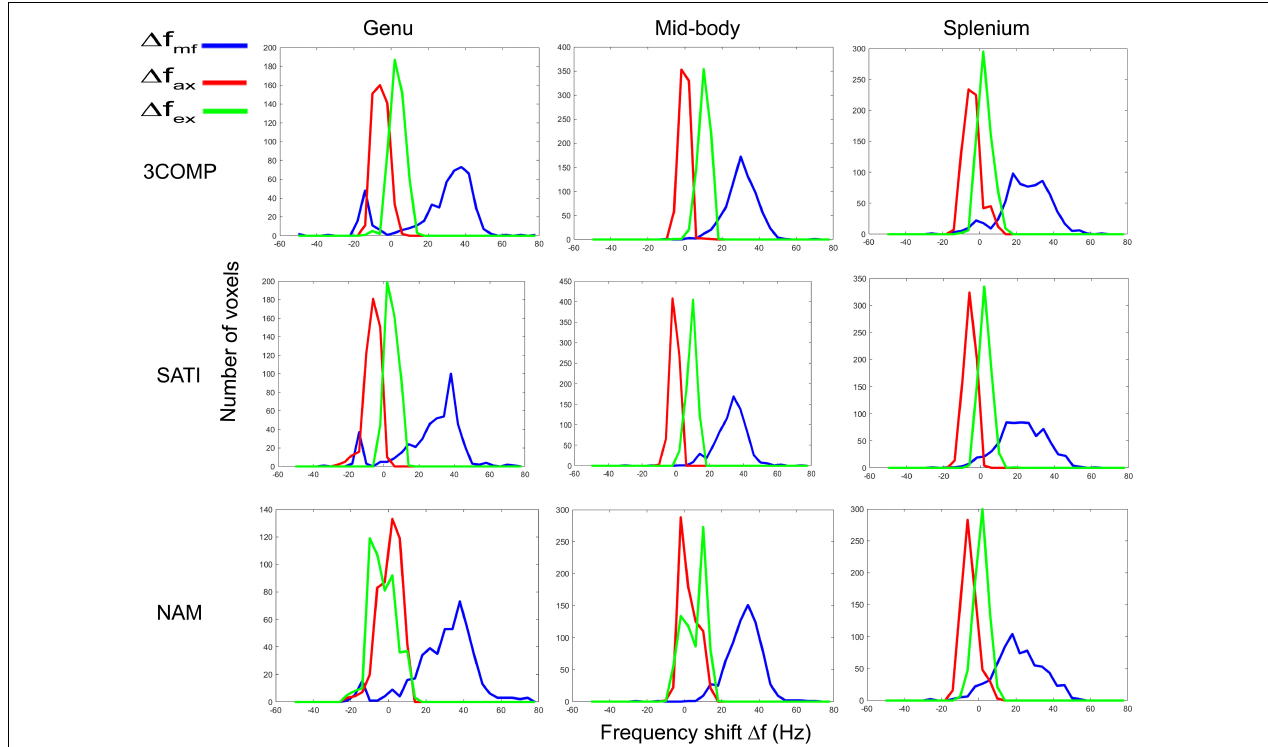
FIGURE 8 | Myelin ( (cid:49) fmf), axonal ( (cid:49) fax) and extracellular ( (cid:49) fex) frequency shift distributions for calculated in three corpus callosum sub-regions. Results provided are for only the three signal compartment models (3COMP, SATI, and